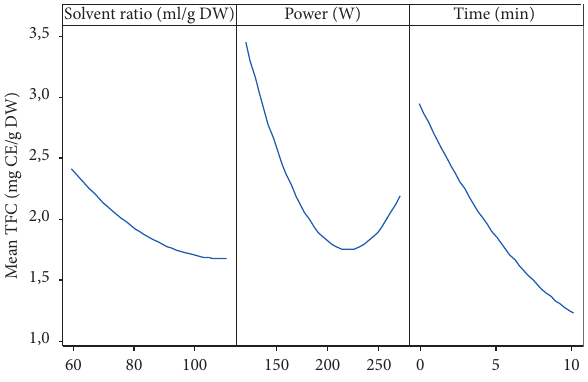
Figure 3: Effects of solvent/raw material ratio, power, and time on TFC. Table 5: Evaluation of quadratic model: P value, F value, RC, CF (contribution factor, %), AADM, and Bf for phenols and